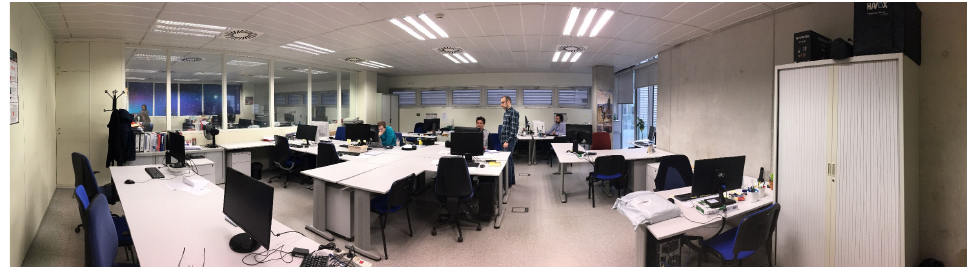
Figure 1. View of the propagation environment where the channel measurements were collected.